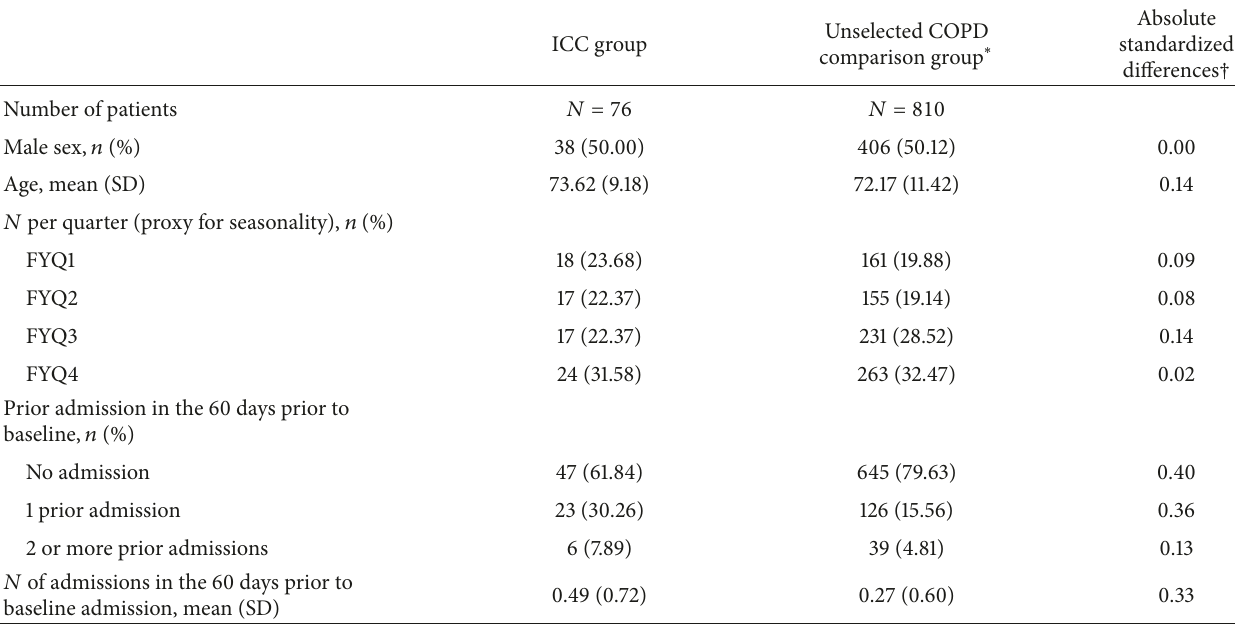
Table 5: Baseline characteristics within the unselected